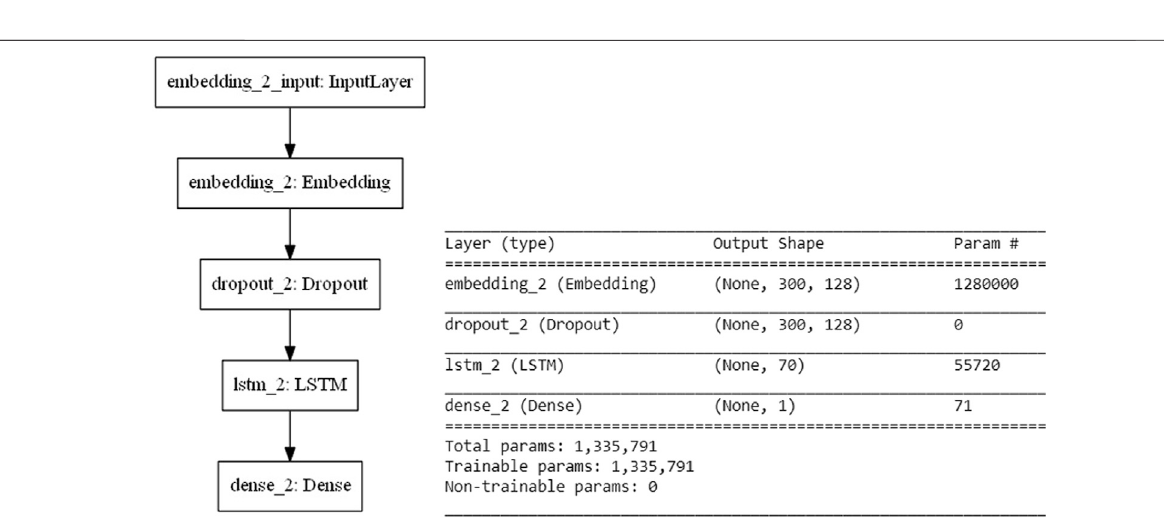
Frontiers in Applied Mathematics and Statistics |